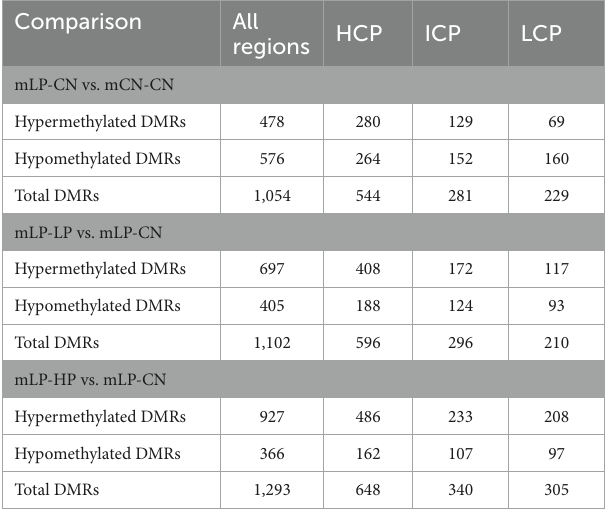
TABLE 1 Number of differentially methylated CpG sites of promoter regions in the kidney for comparisons between treatment groups.